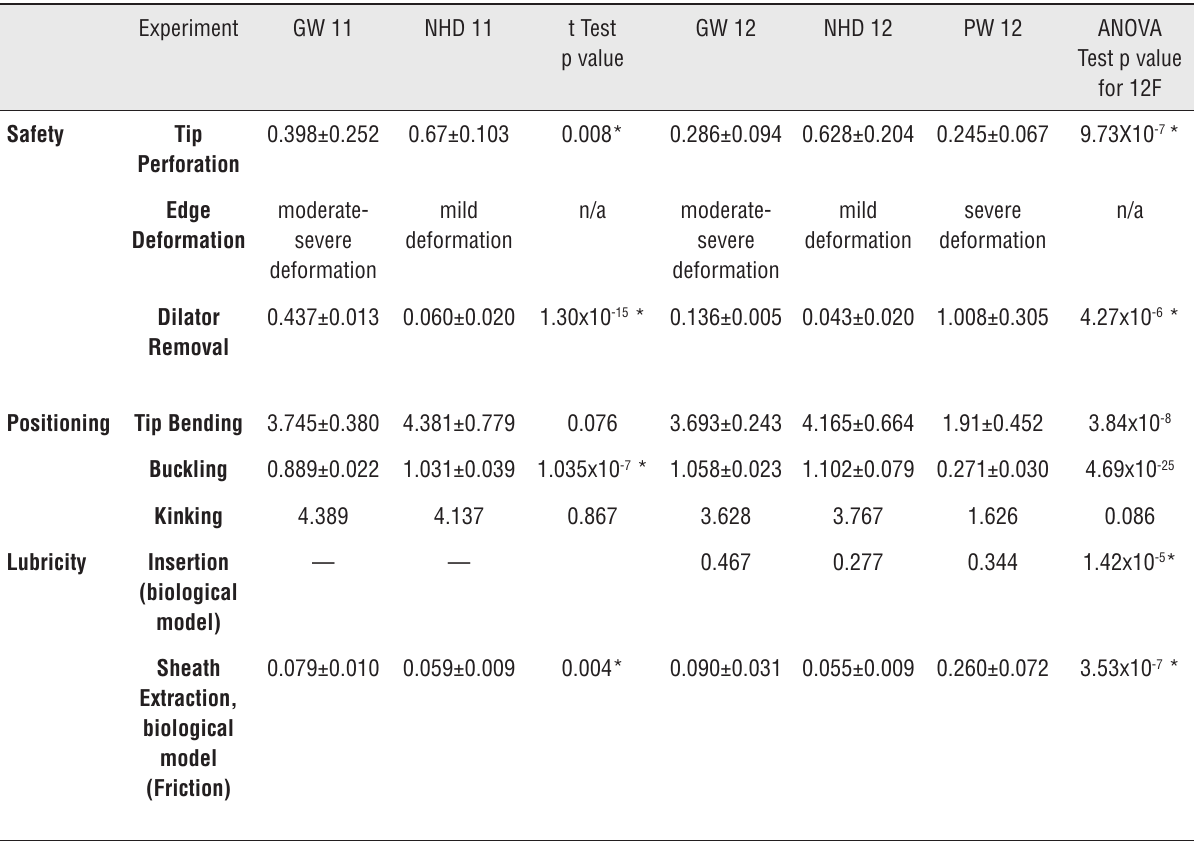
Table 3 - Mean forces (lbs) for safety, positioning and lubricity